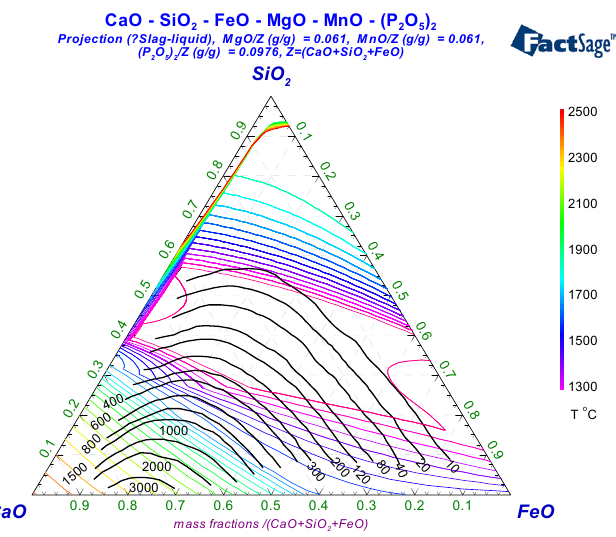
Figure 1. The superimposed liquidus diagram and the iso-phosphorus partition ratio diagram of the CaO-SiO 2 -FeO-MgO-MnO-P 2 O 5 six-element slag system.